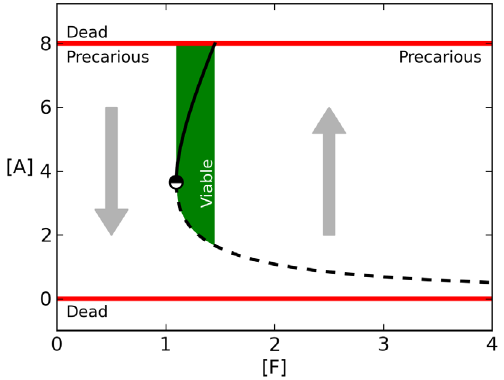
Figure 1. Equilibria, and the viable and precarious regions in the dynamical model of the metabolism. In the presented model, the system is only considered alive if 0 v ½ A (cid:2) v 8 . Given this constraint and the intrinsic metabolic dynamics described by Equation 3, two regions emerge: the precarious region (states for which ½ F (cid:2) must be changed if the system is to persist) and the viable region (states for which no change in ½ F (cid:2) is necessary to avoid death).